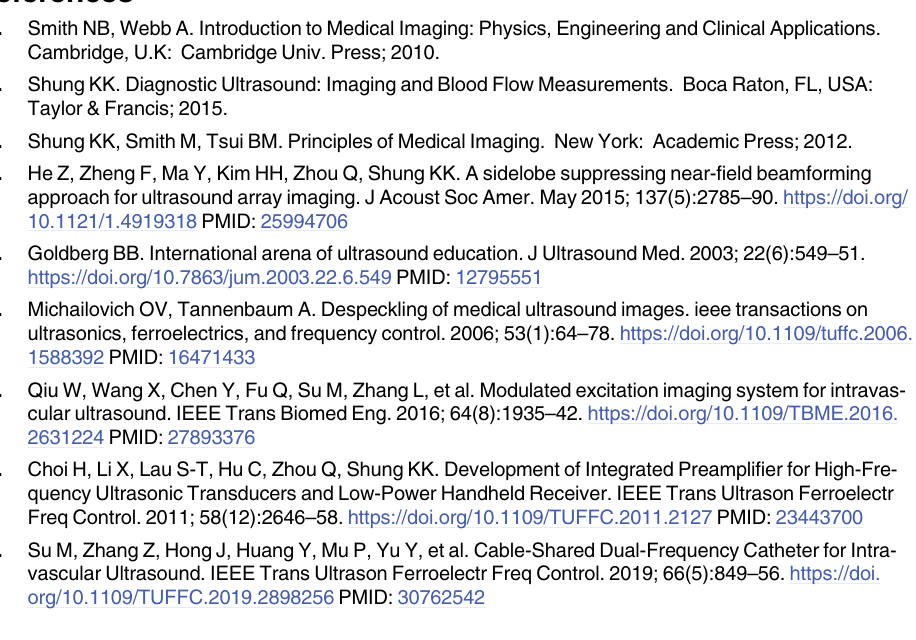
S1 Table. Amplifier performance measurement